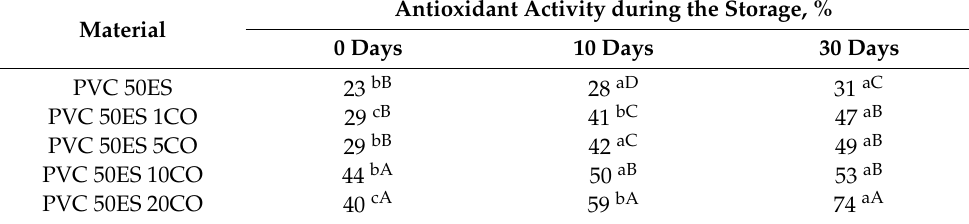
Table 5. Radical DPPH* scavenging capacity